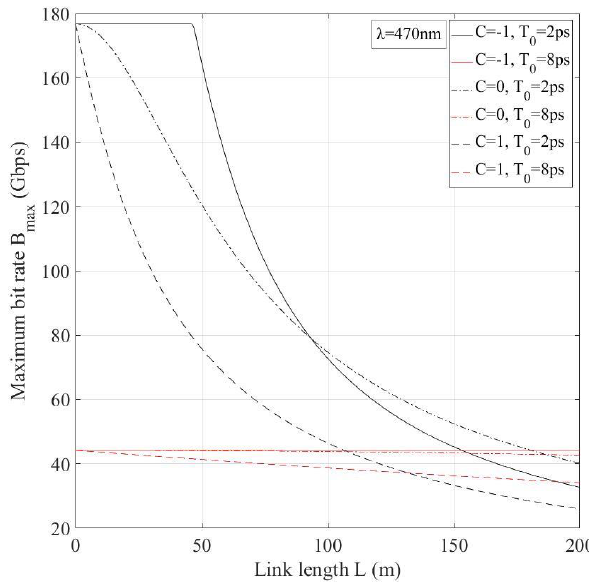
Figure 3. Maximum bit rate, R max , as a function of the propagation distance for various cases of input pulsewidth and chirp at 50 m depth.